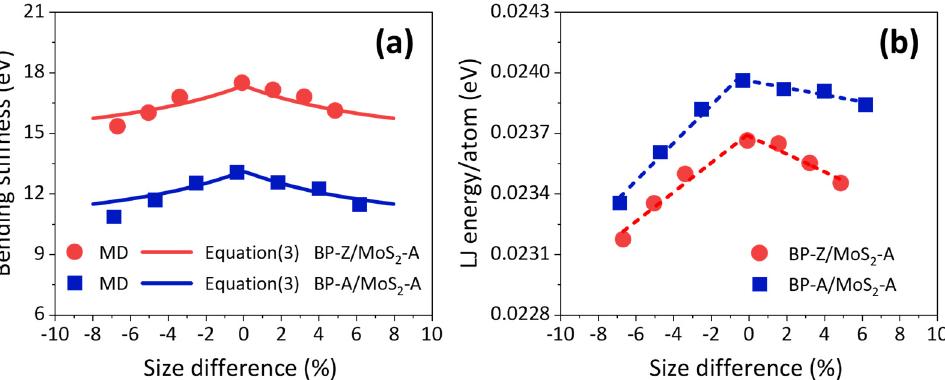
Figure 5. ( a ) The variations of bending stiffnesses of BP-A/MoS 2 -A and BP-Z/MoS 2 -A with the size differences. Here, the scatters represent the computational results of MD simulations. The solid lines are the predicted results based on Equation (3). ( b ) The relationships between the LJ energy/atom and size difference. The dotted lines are the fitting lines.